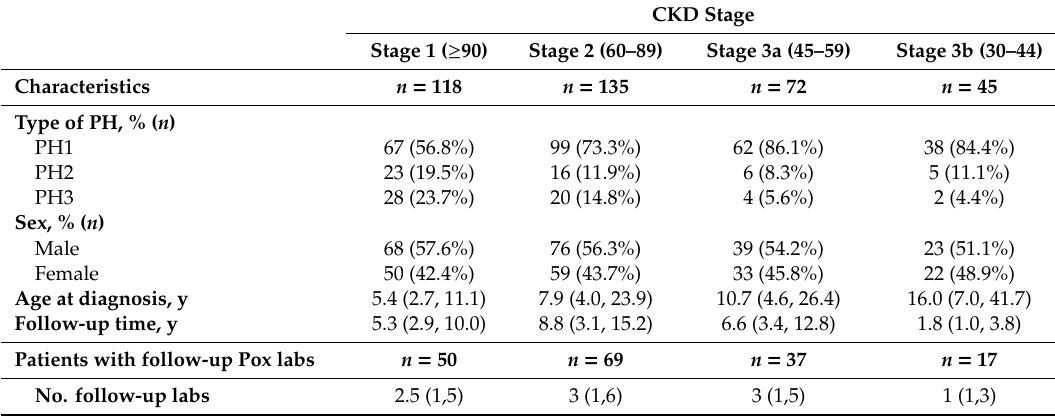
Table 1. Clinical characteristics of patients with primary hyperoxaluria who did not have ESKD at or before diagnosis.